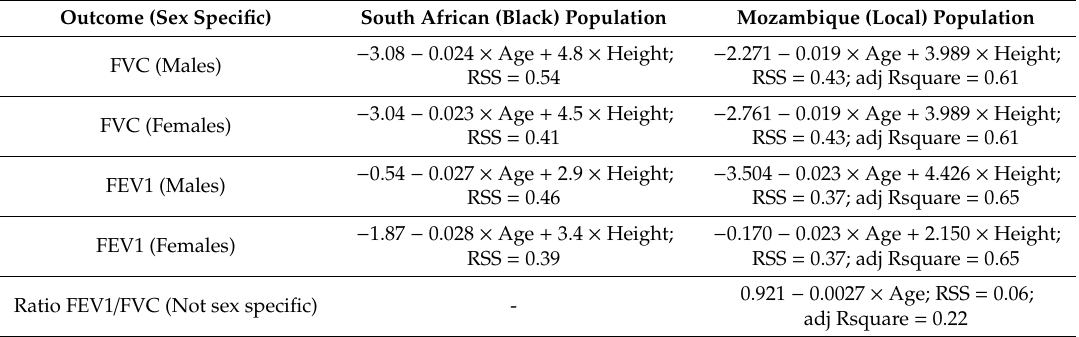
Table 2. New spirometric prediction equations obtained from the study sample in comparison to the South African equations.